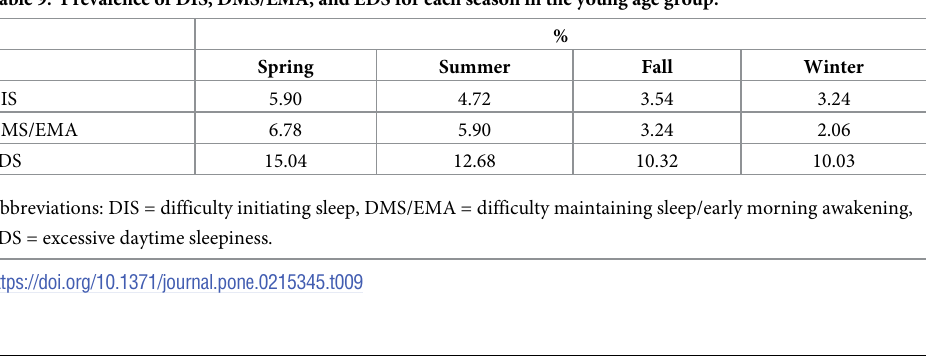
Table 9. Prevalence of DIS, DMS/EMA, and EDS for each season in the young age